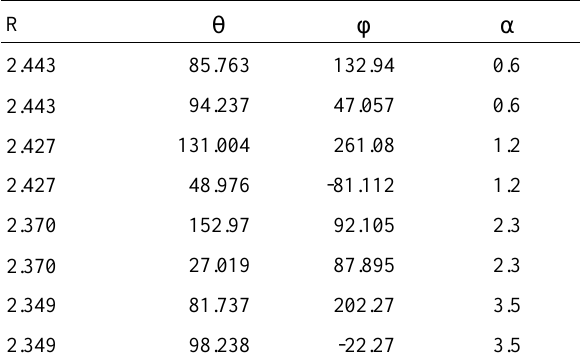
Table 1. Ligand coordinates (R in units of 10 -8 cm and angles in degrees) and their polarizabilities ( a in units of 10 -24 cm 3 ).